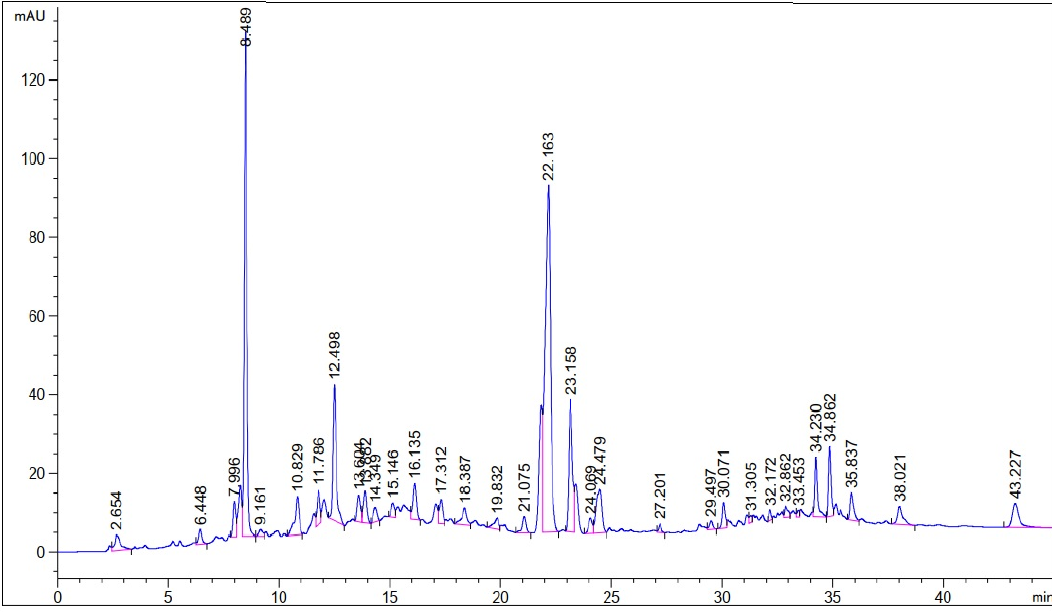
Figure 2. HPLC phenolic profile chromatogram of E. wallichii .